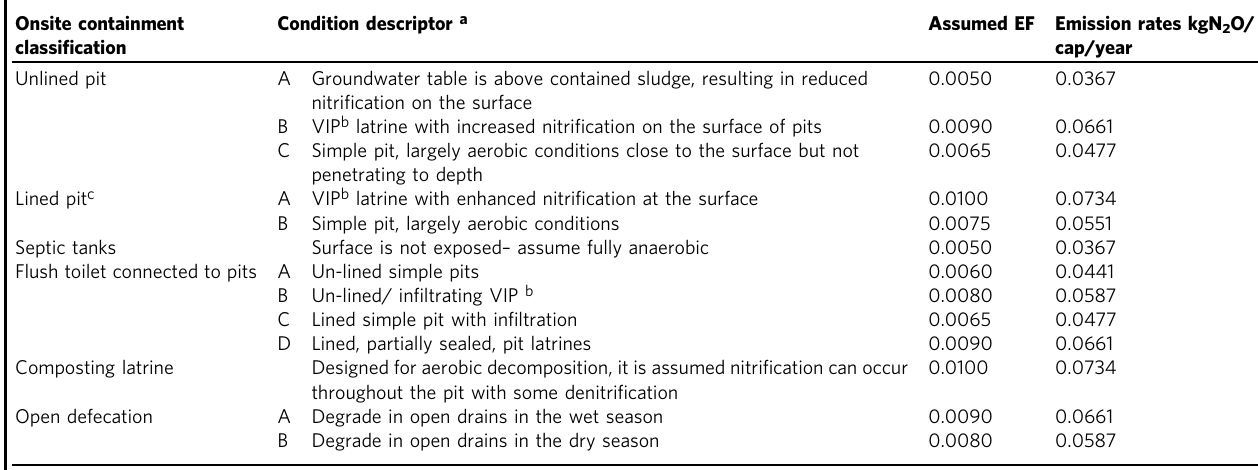
Table 3 Modelled nitrous oxide emissions factors and per capita nitrous oxide emission rates for typical containment systems in